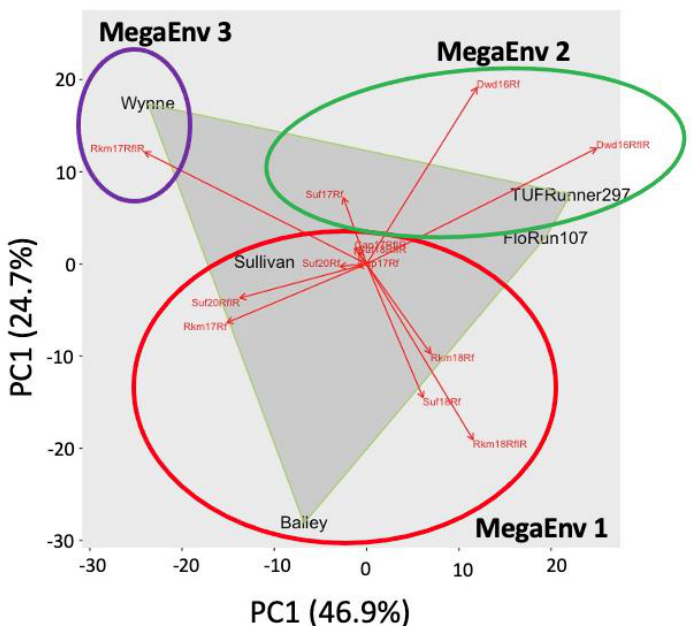
Figure 9. AMMI2 biplot (PC1 vs. PC2) for pod yield (kg/ha) with five cultivars (G01—Bailey, G02—FloRun107, G03—Sullivan, G04—TUFRunner297, G05—Wynne) in 13 environments (E01—Cap17Rf, E02—Cap17RfIR, E03—Dwd16Rf, E04—Dwd16RfIR, E05—Rkm17Rf, E06—Rkm17RfIR, E07—Rkm18Rf, E08—Rkm18RfIR, E09—Suf17Rf, E10—Suf18Rf, E11—Suf18RfIR, E12—Suf20Rf) showing mega-environments and their respective high yielding cultivars.